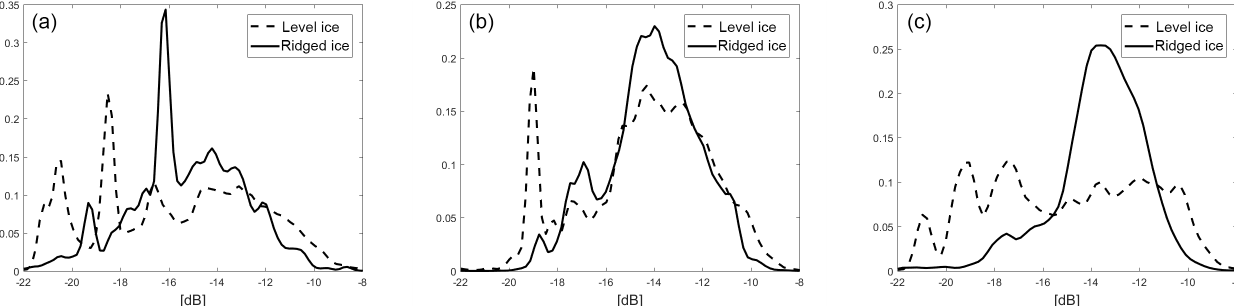
Figure 7. The monthly HH-polarization backscattering coefficient distribution for level (dashed line) and ridged (solid line) ice areas. The results are for January (a) , February (b) and March (c)